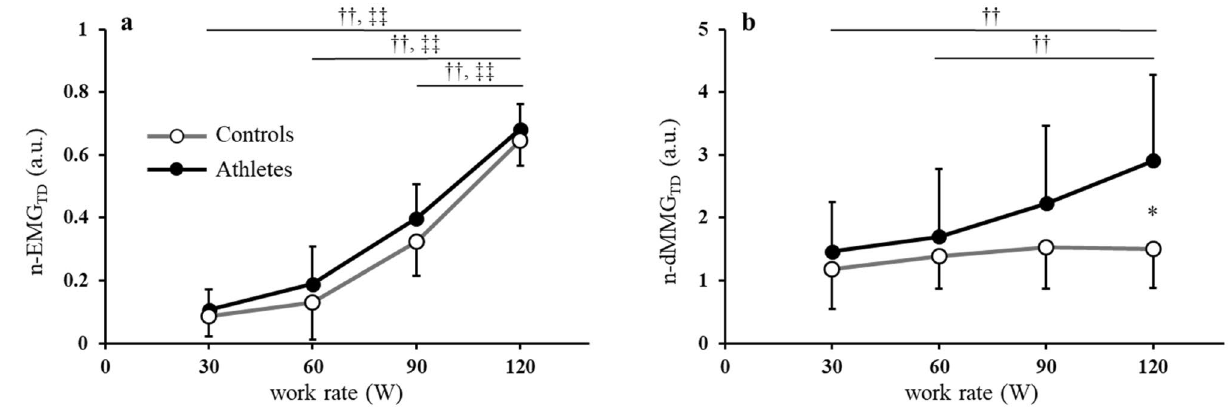
Figure 2. Relationship between work rate and ( a ) n-EMG TD , ( b ) n-dMMG TD , in controls (open circles) and athletes (closed circles). All quantitative data are expressed as means ± SD; n = 8, 8 for control and athlete groups, respectively. *p < 0.05 vs. controls. †† p < 0.01: within MMG subjects, ‡‡ p < 0.01: within EMG subjects.